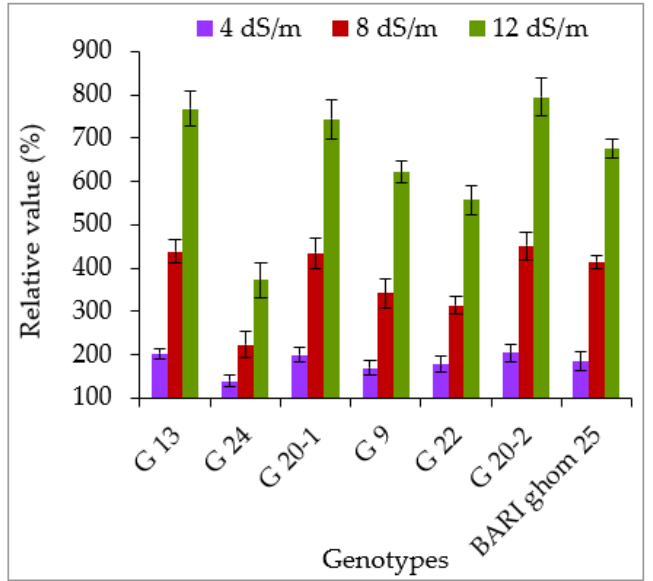
Figure 10. Relative value of proline content in leaf of wheat genotypes under various salinity levels. The vertical bar indicates average data of five independent replicates ( n = 5). Error bars represent standard error.